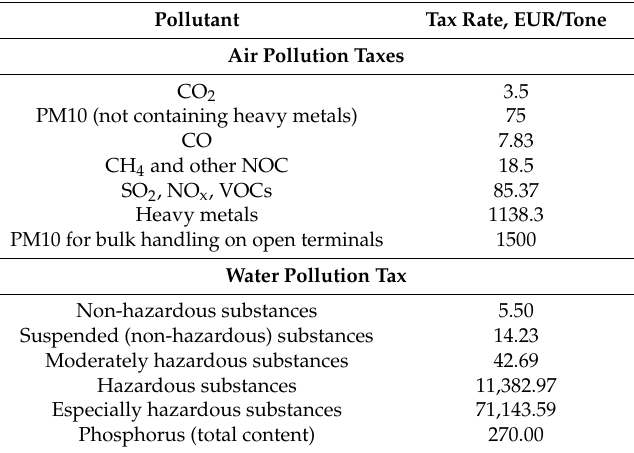
Table 4. Pollution tax rates in Latvia, 2015